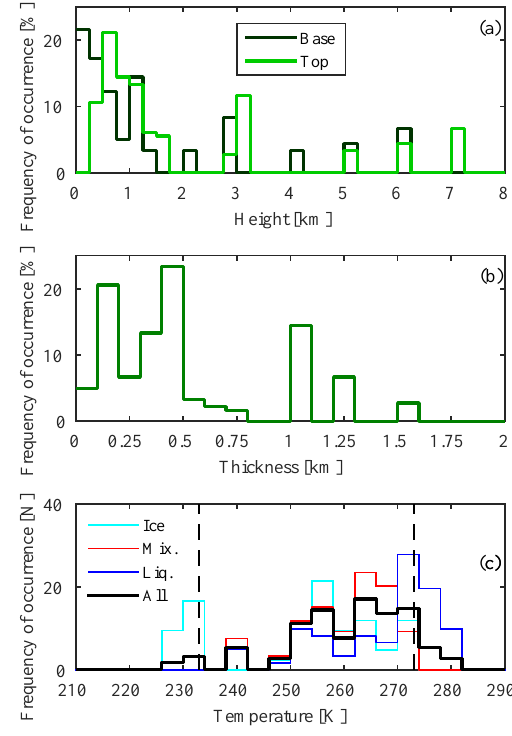
of 222 simulated clouds. (a) Cloud base height (black) and cloud top height (gray), (b) physical thickness, and (c) cloud mean tempera- ture. The vertical lines in (c) represent the physical limits imposed on the minimum temperature that liquid may be included (233K) and the maximum temperature that ice may be included (273K). Between these thresholds examples of liquid-only, ice-only, and mixed-phase clouds are